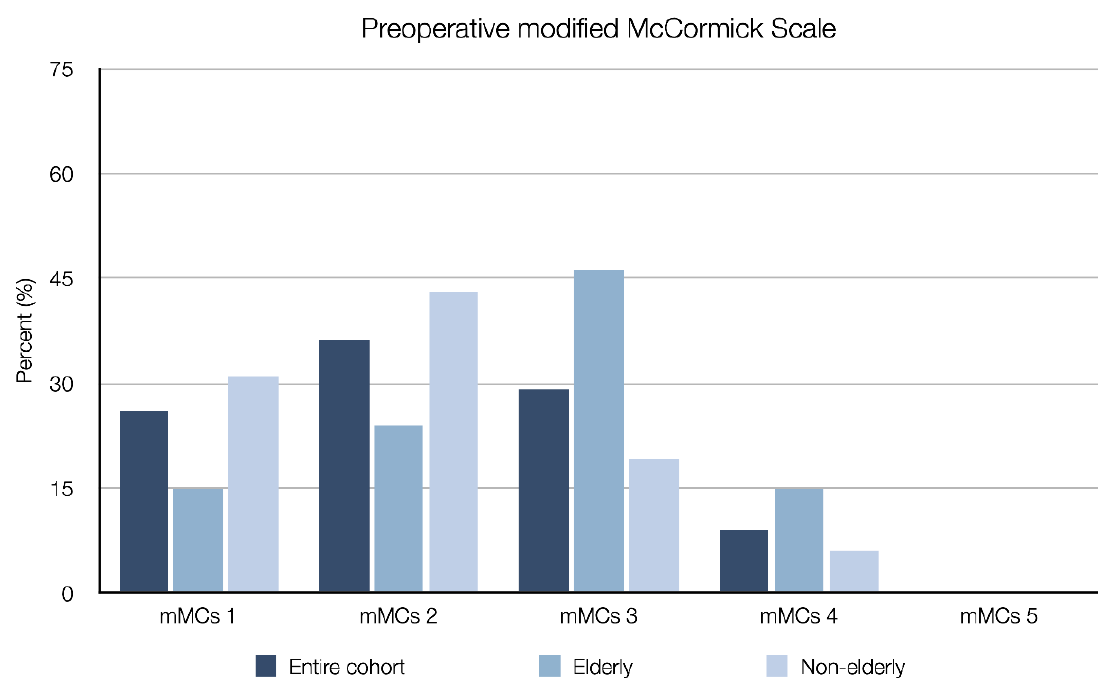
Figure 6. Bar chart showing preoperative modified McCormick scale in elderly ( ≥ 70 years) and non-elderly (18–69 years) patients, as well as the entire cohort, who underwent surgical resection of spinal meningiomas.